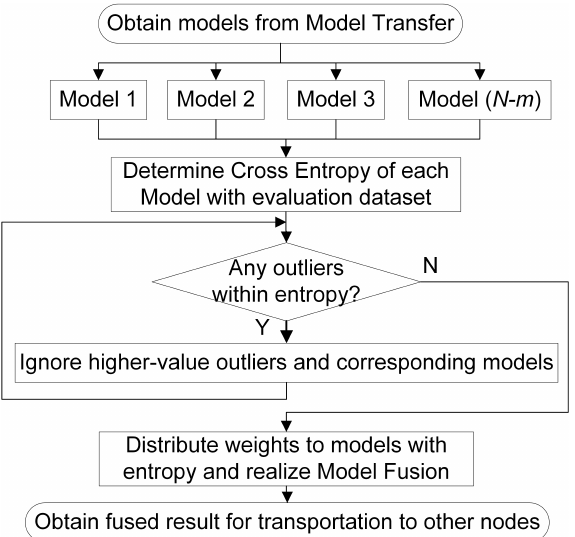
Figure 5. Model and network process: dynamic adaptive outlier monitoring-based model selection and weight adjustment-based model